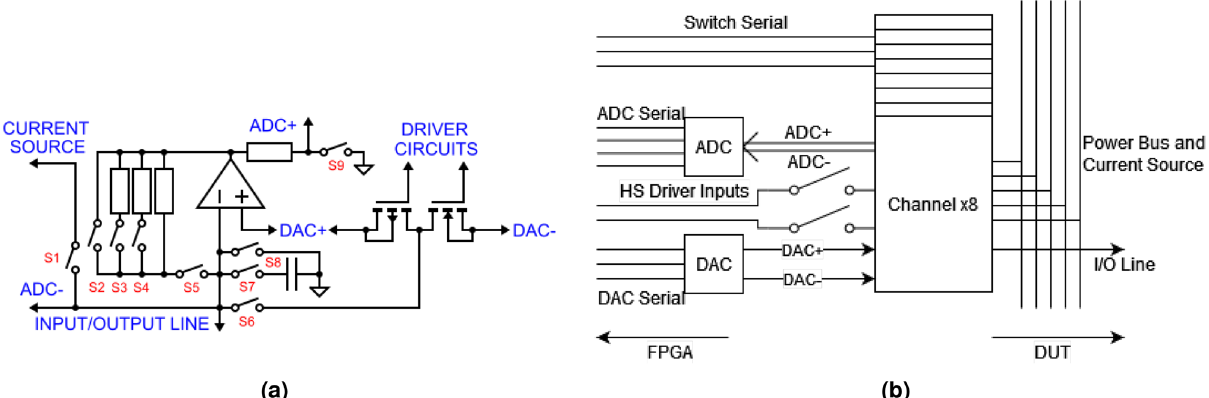
Figure 2. ( a ) is a schematic of the channel architecture. Significant wires are labelled in blue. Analogue switches are labelled in red. ( b ) is a schematic of the structure of the channel